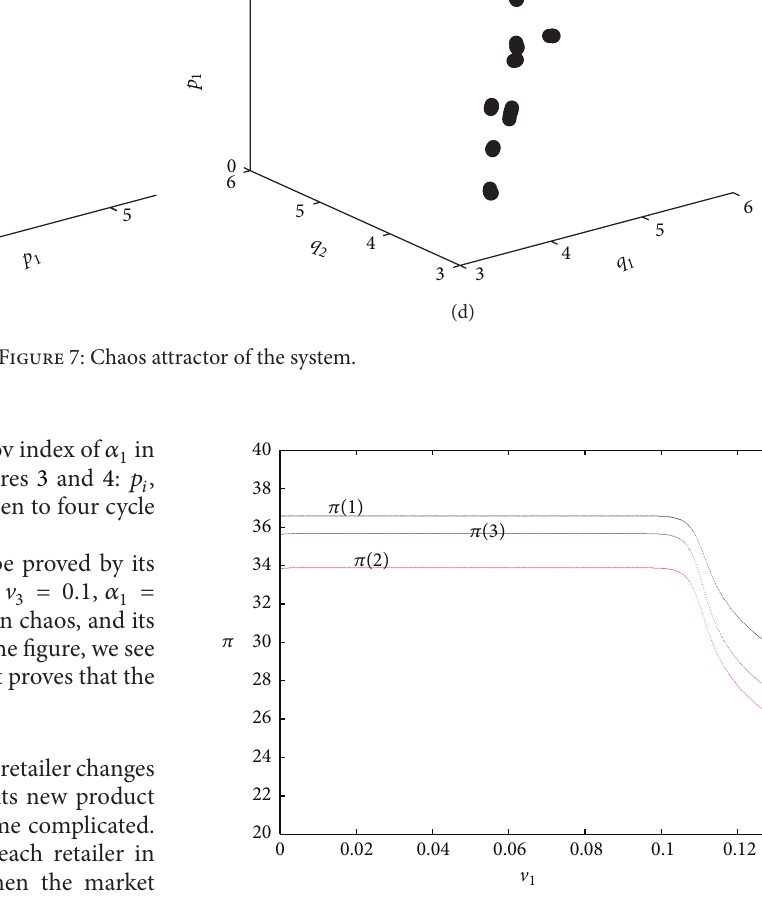
Figure 8: Track figure of profit with V 1